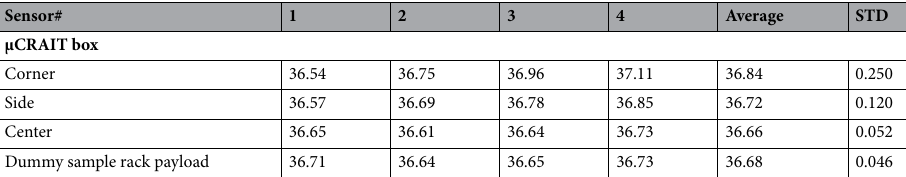
= T ref ,32 cor ,32